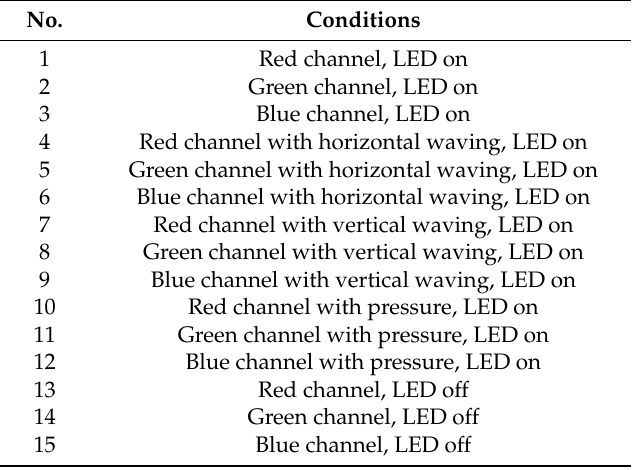
Table 1. Experimental conditions.